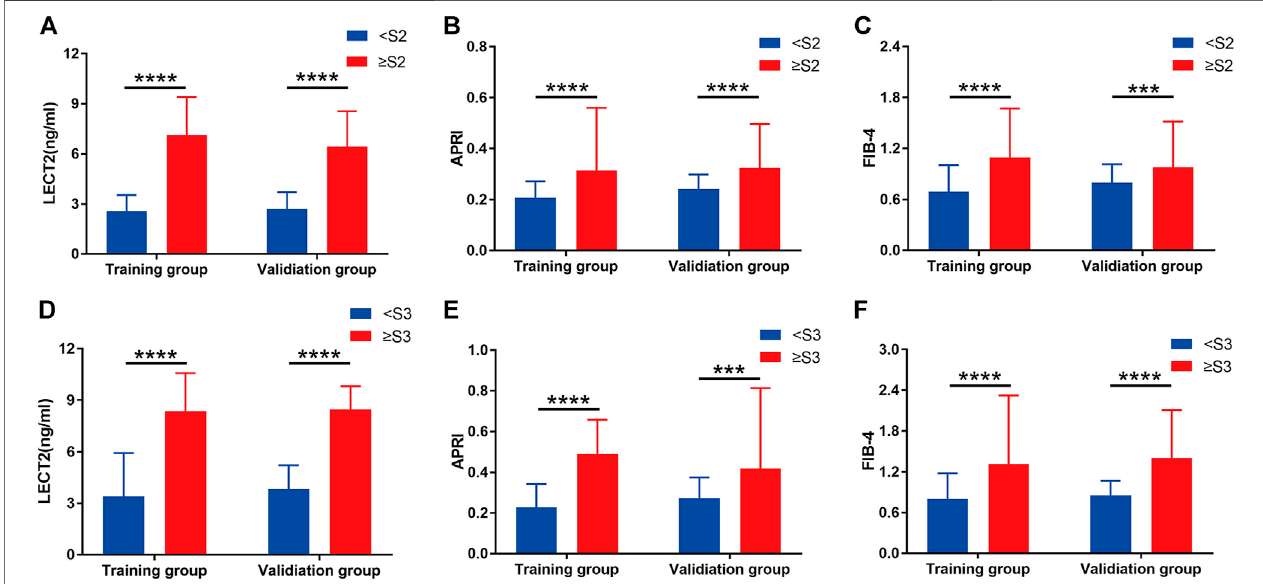
FIGURE1| Groupedbarchartdepictingtheserumliver fi brosismarkerlevelsinpatientswithCHBinthetraininggroupandvalidationgroup. (A) , (B) ,and (C) show theserumLECT2,APRI,andFIB-4intheliver fi brosisstage < S2and ≥ S2,respectively. (D) , (E) ,and (F) showtheserumLECT2,APRIandFIB-4intheliver fi brosisstage < S3 and ≥ S3, respectively. The differences between < S2 and ≥ S2 or < S3 and ≥ S3 for each of the three liver fi brosis markers were signi fi cant. *** p < 0.001, **** p <